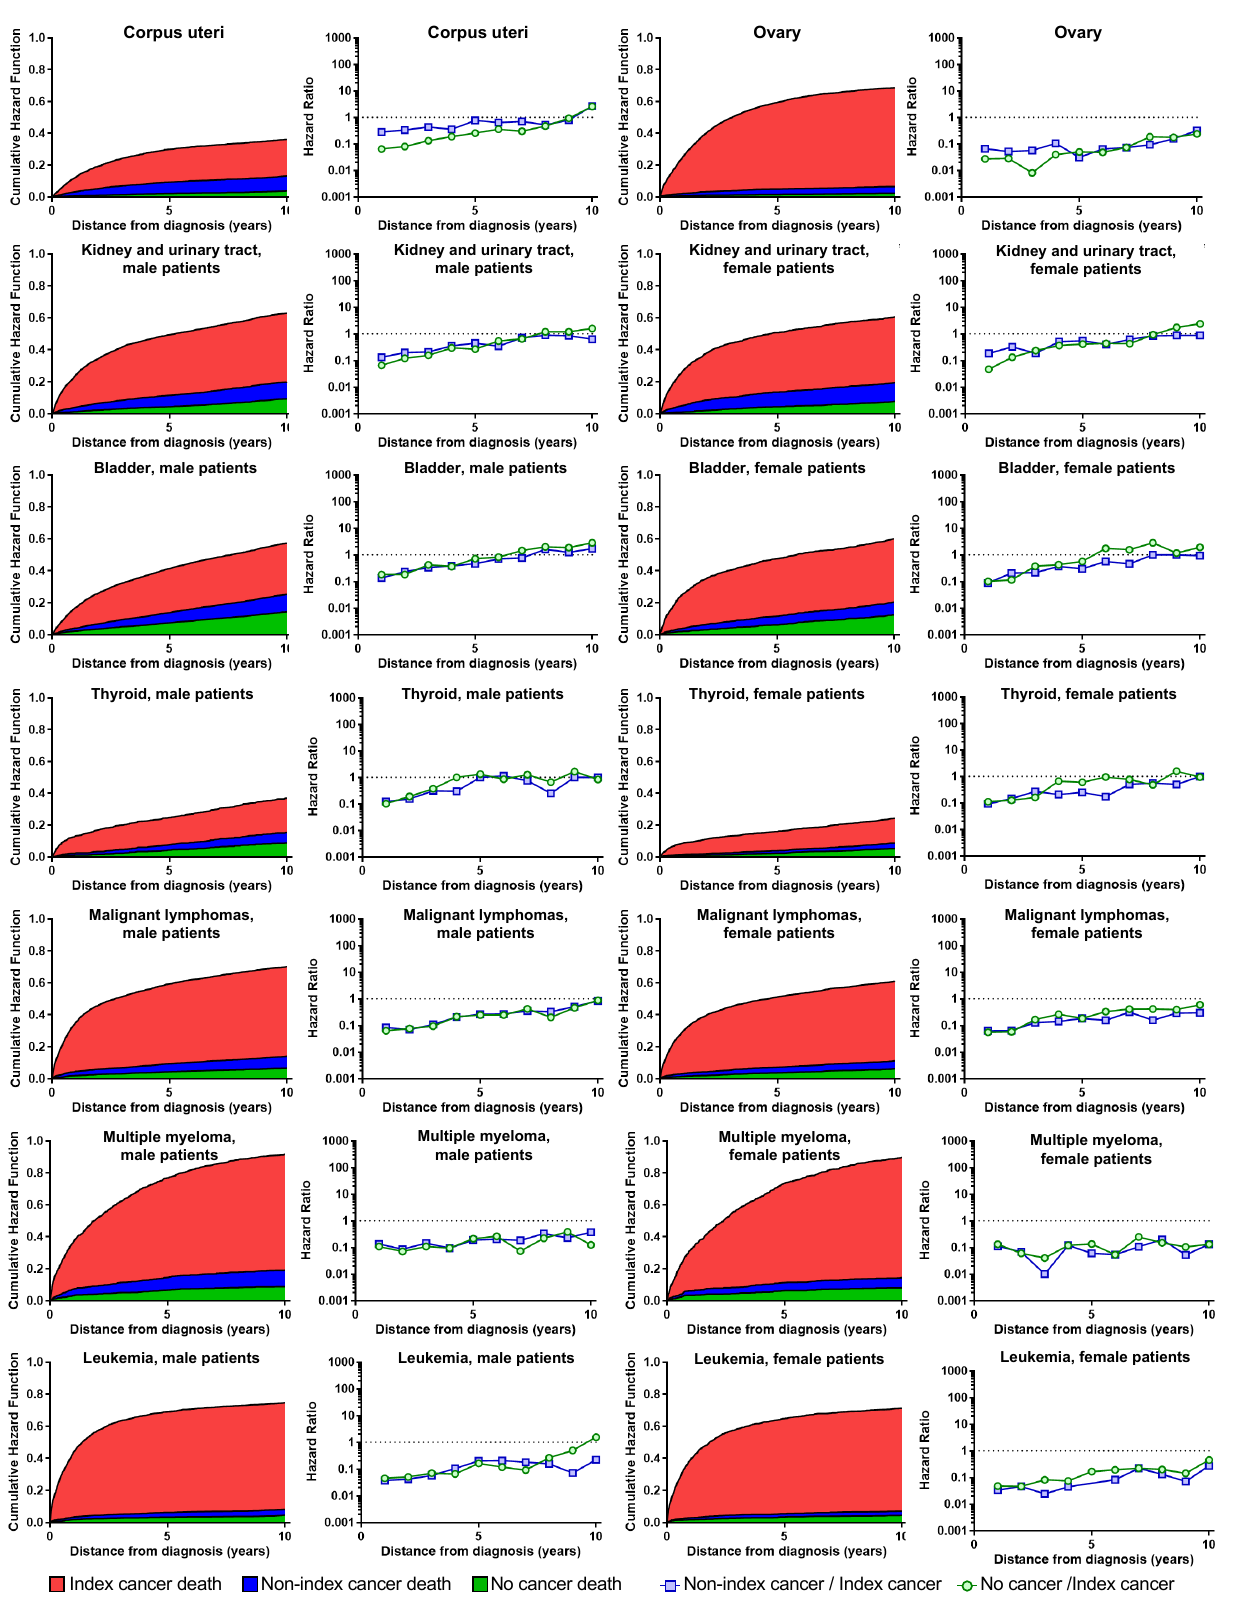
Figure 2. Cumulative hazard rate and hazard ratio by cause of death. The red area shows the index cancer death, the blue area shows the other cancer deaths, the green area shows the non-cancer deaths, and the other white area shows the cumulative survival rate